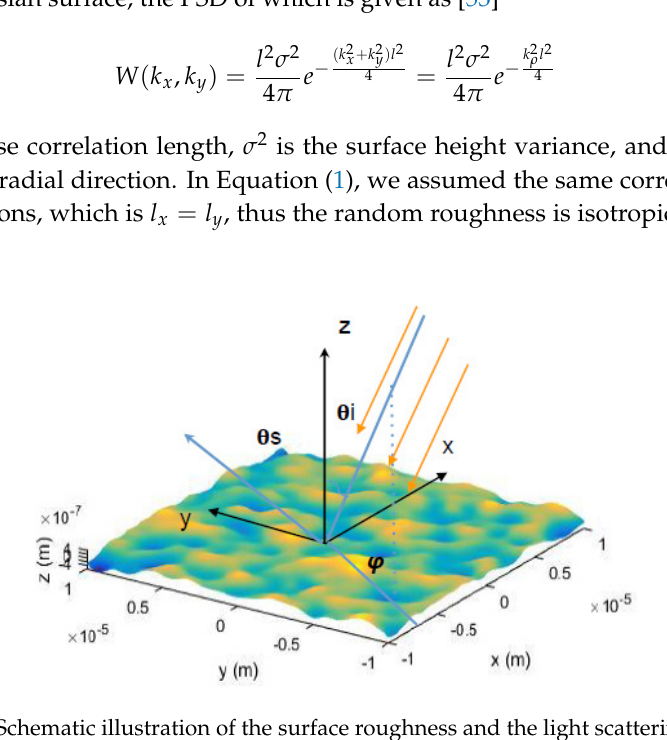
Figure 1. Schematic illustration of the surface roughness and the light scattering